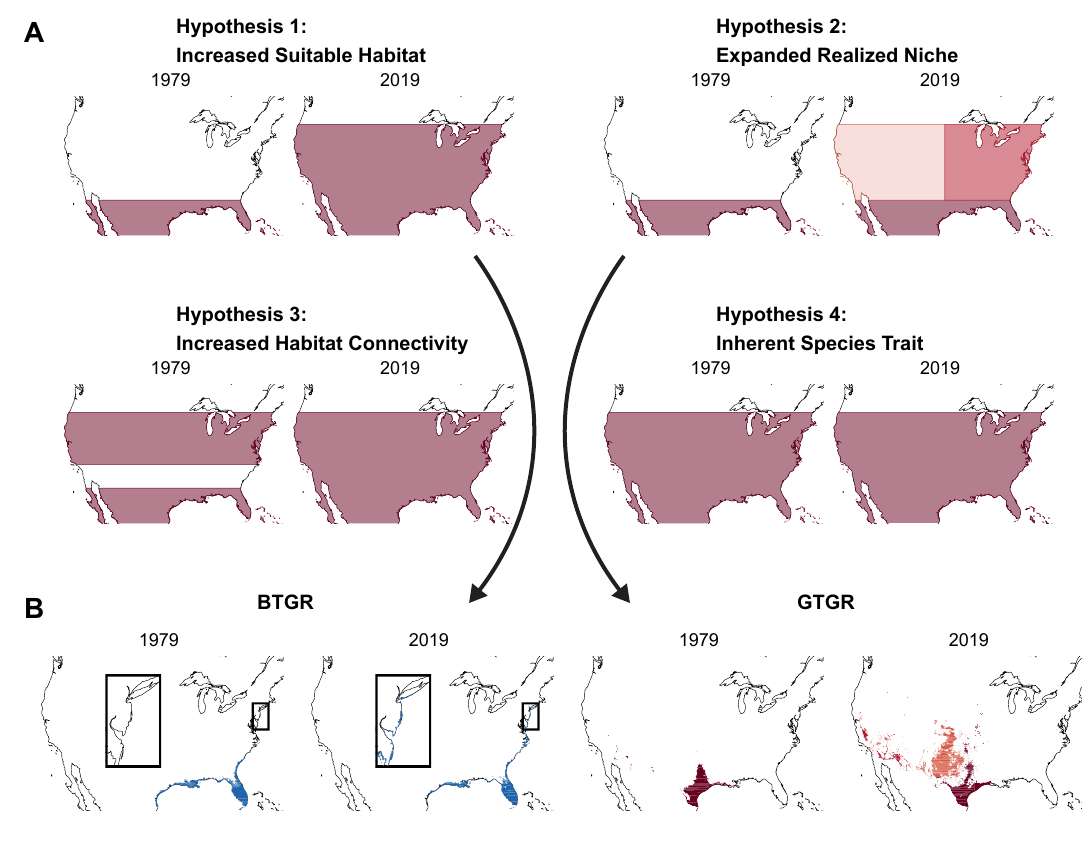
Figure 1 – Comparison between the predicted patterns depending on the forces that facilitated range expansion and habitat suitability predicted by the species distribution models (SDMs) for the great-tailed grackle (GTGR) and boat-tailed grackle (BTGR). (A) The pairs of plots display the predic- tions for the historic and current models if increased suitable habitat (Hypothesis 1), expanded real- ized niche (Hypothesis 2), increased habitat connectivity (Hypothesis 3), or other inherent species trait(s) (Hypothesis 4) drove range expansion. (B) The suitable habitat predictions for the historic and current models based on environmental data from 1979 and 2019. We used the maximum- sensitivity-specificity thresholds for each model (great-tailed grackle current: 0.4440, boat-tailed grackle current: 0.4780, great-tailed grackle historic: 0.4635, boat-tailed grackle historic: 0.3935) to assign habitat as suitable. The different colors in the great-tailed grackle map indicate that some environmental conditions within its 2019 expanded range were not found in its 1979 range. The arrows connect the species ranges to the most supported predicted range